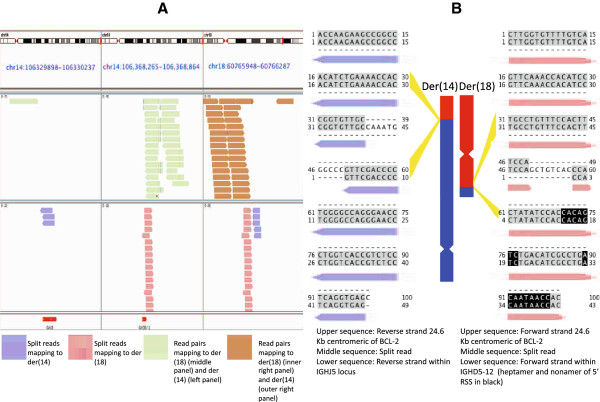
Derivative chromosomes for the t(14;18) IGH-BCL2 translocation in the DB cell line. (A) Full length and split-reads mapping to both der(14) and der(18). Der(14) reads map to the BCL-2 and IGHJ5 loci and der(18) reads map to the BCL-2 and IGHD5-12 loci. Red segments in the bottom panel indicate IGH D and J segments. The small gap between pink and blue split-read pileups in the right panel covers 12 bp of sequence deleted before recombination. This junction was complex with deletion of 12 bases and insertion of 8 (shown in B, right side). The panel on the left is 38.5 Kb centromeric of the middle panel, and is shown as a separate panel because the intervening sequence was deleted from der(14). (B) The rearrangements were confirmed by Sanger sequencing, with the recovered sequences matching the junction spanning sequences found with split-reads. The split-read sequences are shown aligned to the two sequences present in the reference genome (hg19) from each junction. Aligned nucleotides are in gray, N-regions are in white, and the heptamer and nonamer of IGHD5-12 are shown in black. Both junctions contain N-regions, 11 N-region nucleotides on der(14) and 8 N-region nucleotides on der(18).